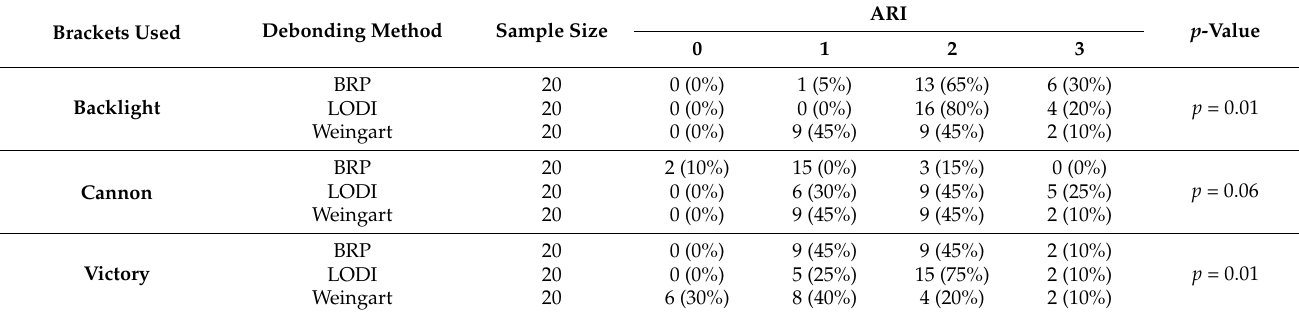
Table 5. Comparison of ARI scores between groups according to the debonding method.